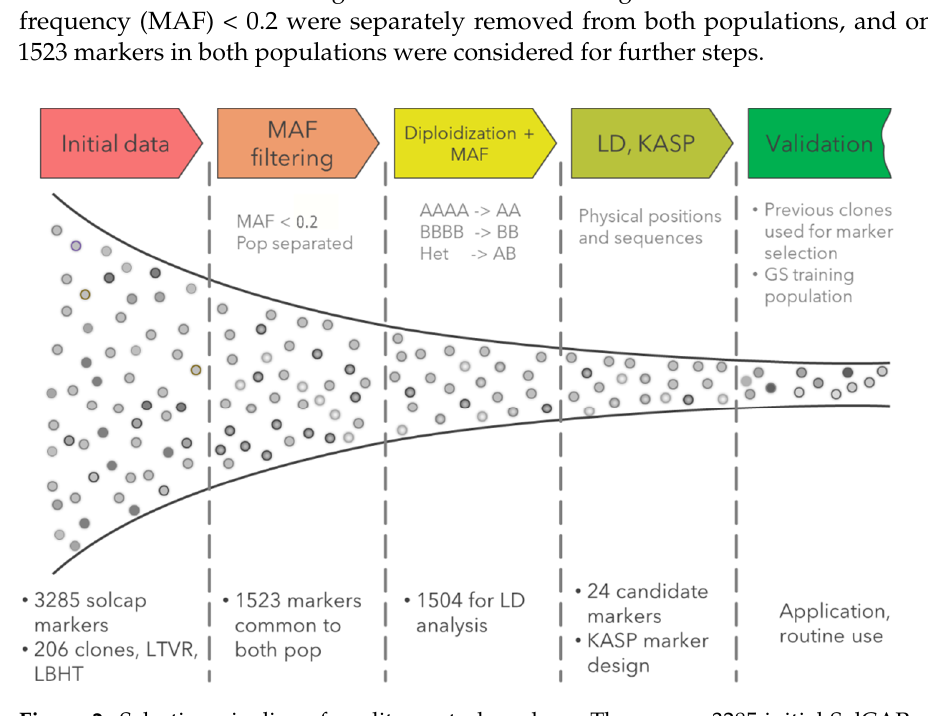
Figure 2. Selection pipeline of quality control markers. There were 3285 initial SolCAP markers that had no missing data. GS, genomic selection; KASP, kompetitive allele specific PCR; LBHT, late blight heat tolerance population; LD, linkage disequilibrium; LTVR, lowland tropics virus resistant population; MAF, minor allele